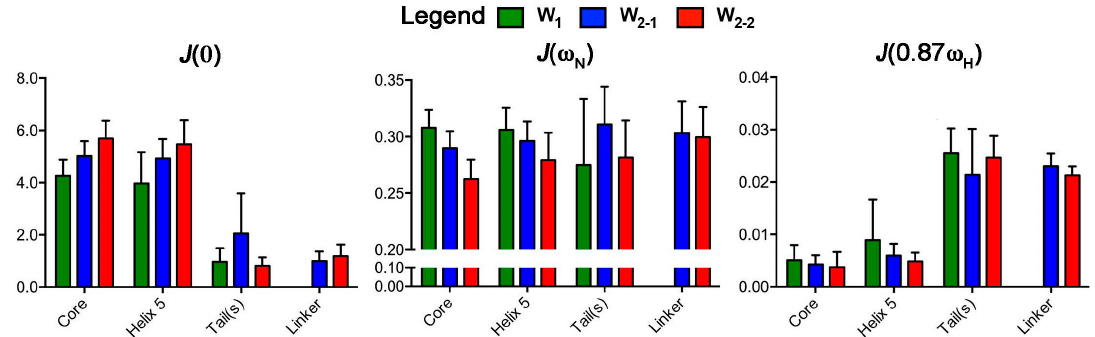
Figure 4. Bar graphs representing the mean J (0), J ( ω N ), and J (0.87 ω H ) (error bars: standard deviation) over key W unit regions. These were specifically defined as the core (residues 12–149 (W 1 , W 2-1 ) and 212–349 (W 2-2 )), linker (residues 150–211 from W 2-1 and W 2-2 ), tails (W 1 : residues 1–11 and 150–199; W 2 : residues 1–11 and 350–400), and helix 5 (residues 135–149 (W 1 , W 2-1 ) and 335–349 (W 2-2 )).